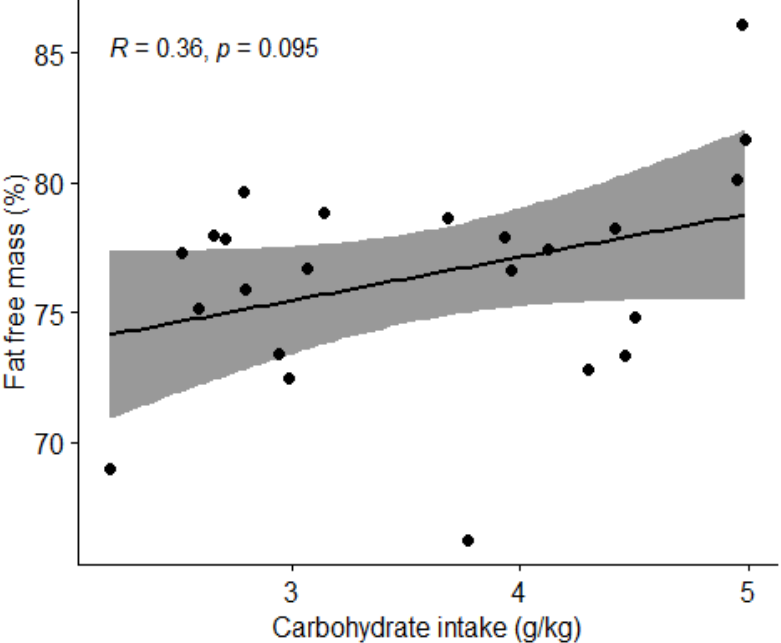
Figure 9. Correlation between carbohydrate intake and percentage of lean body mass in football players. Dots represent individual participants ( n = 23). Grey shaded area indicates 95% CI.